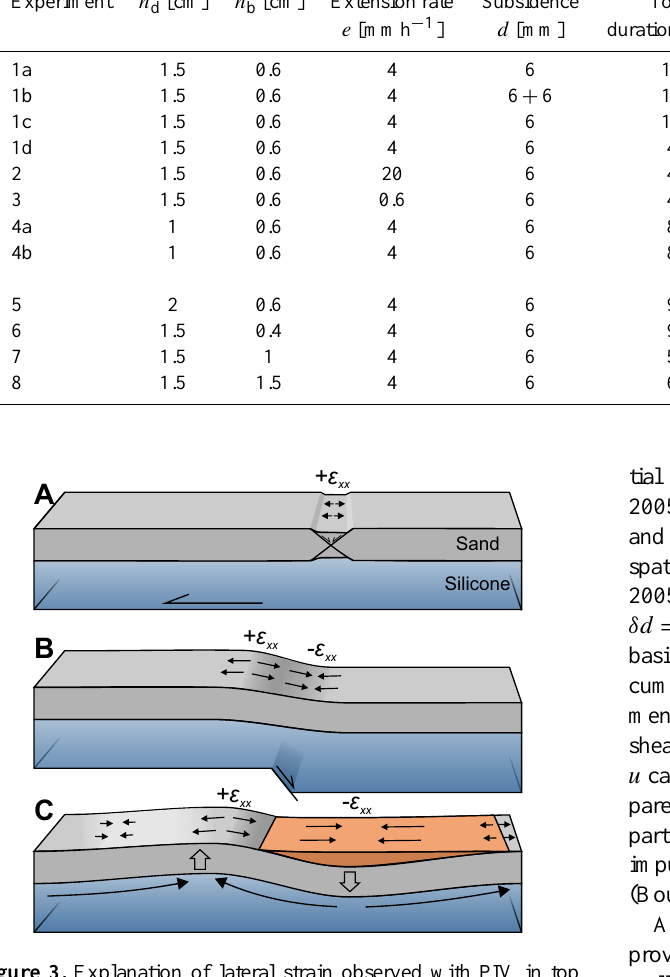
Figure 3. Explanation of lateral strain observed with PIV in top view (see results). (a) Cover extension, which is due to displace- ment of the basement, is measured as positive lateral strain ( + ε xx ) . (b) Layer bending due to extensional forced folding is accompanied by extension ( + ε xx ) and compression ( − ε xx ) of the sand surface. (c) Similarly, surface uplift due to silicone inflation leads to cre- stal extension ( + ε xx ) . Surface subsidence due to silicone deflation causes compression ( − ε xx )